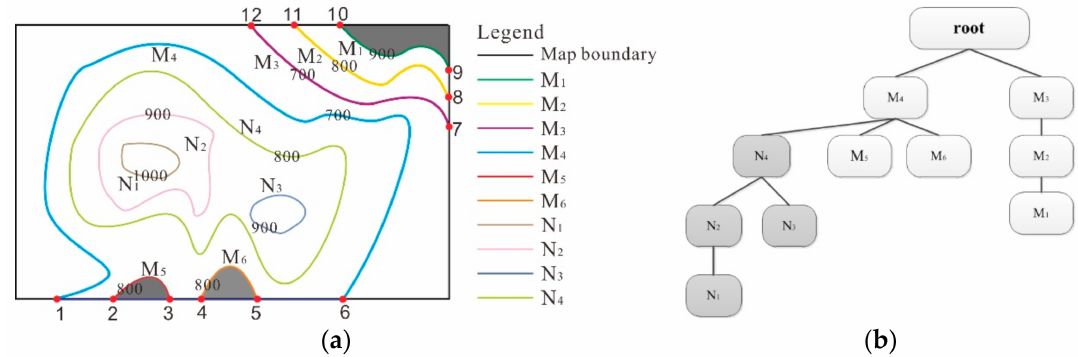
Figure 5. Merging of open- and closed-contour adjacent relation trees: ( a ) complete structure of the contour lines in the area and ( b ) unified adjacent relation